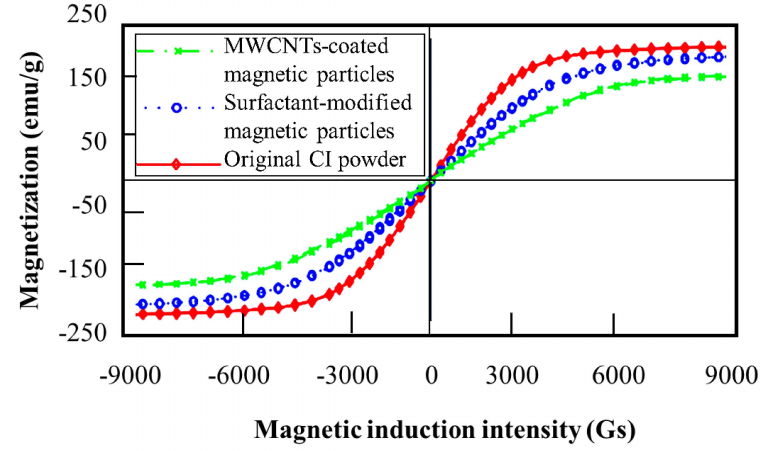
Figure 4. Comparison of magnetization curves of three magnetic particles (1 Gs = 0.0795775 kA = m)